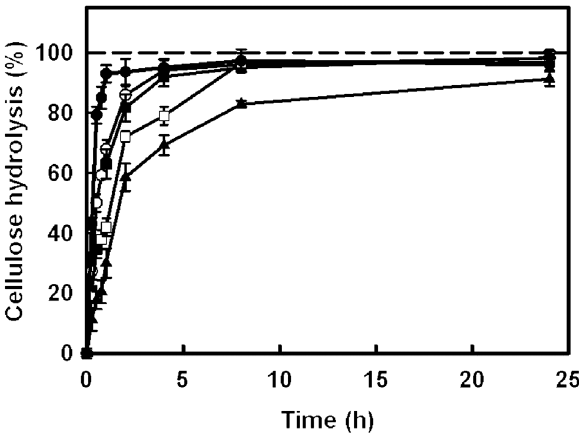
Figure 3 Time course profiles of the enzymatic hydrolysis of regenerated cellulose catalyzed by the combined action of cellulase ( Celluclast 1.5L, 4.6 mg/ml of reaction medium) and cellobiase (Novo- zyme 188, 1.4 mg/ml), at different cellulose concentrations (20 mg/ml ●, 40 mg/ml ○, 60 mg/ml ■, 80 mg/ml □, 100 mg/ml ▴